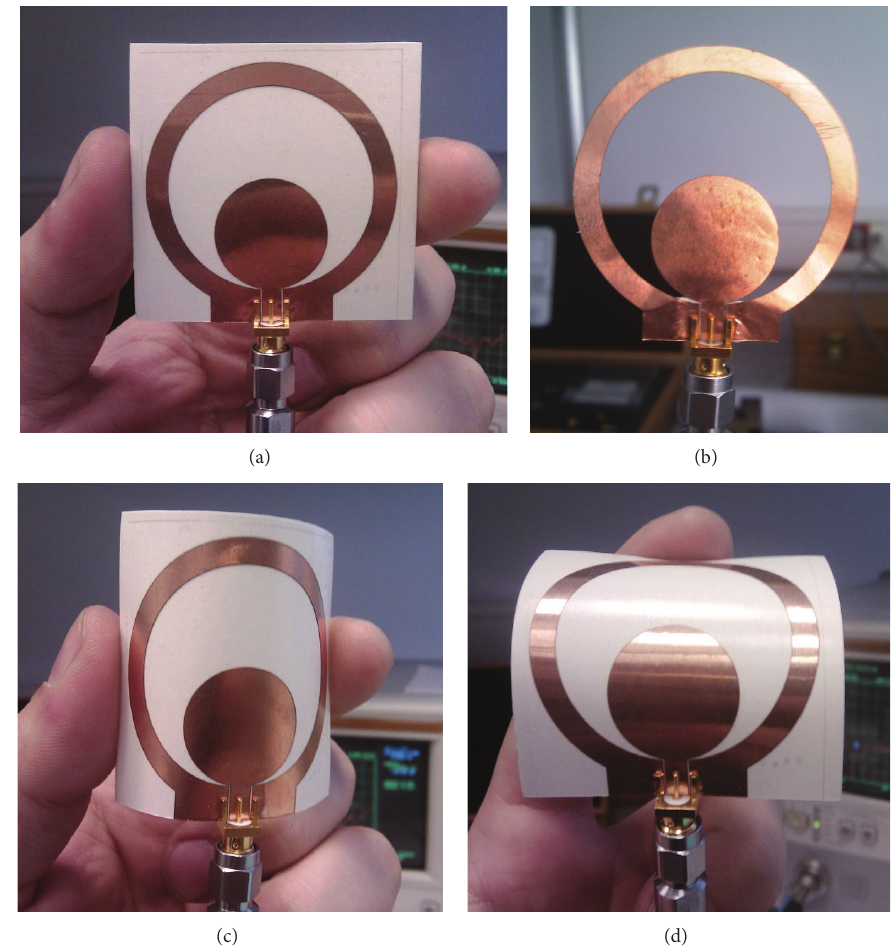
Figure 8: Photographs of the fabricated antenna: (a) planar version on paper, and (b) planar version in air, (c) curved around the 𝑥 -axis, (d) curved around the 𝑦 -axis.